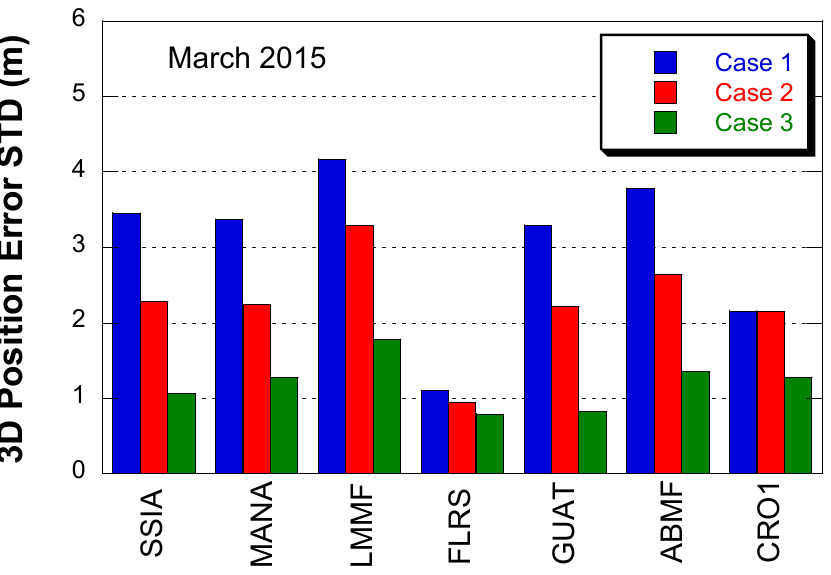
Figure 11. 3D position error STD for different positioning methods at seven IGS stations in March 2015.